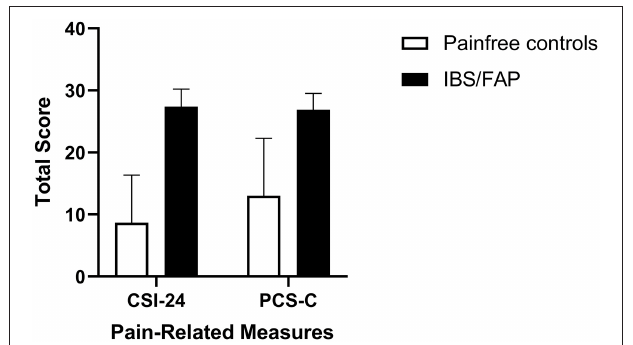
FIGURE 3 | The average level of somatization (CSI-24) and pediatric catastrophizing (PCS-C) in newly diagnosed IBS/FAP patients compared to pain-free controls. Somatization ( p = 0.026), but not catastrophizing ( p = 0.083), was significantly higher in IBS/FAP patients compared to pain-free controls.